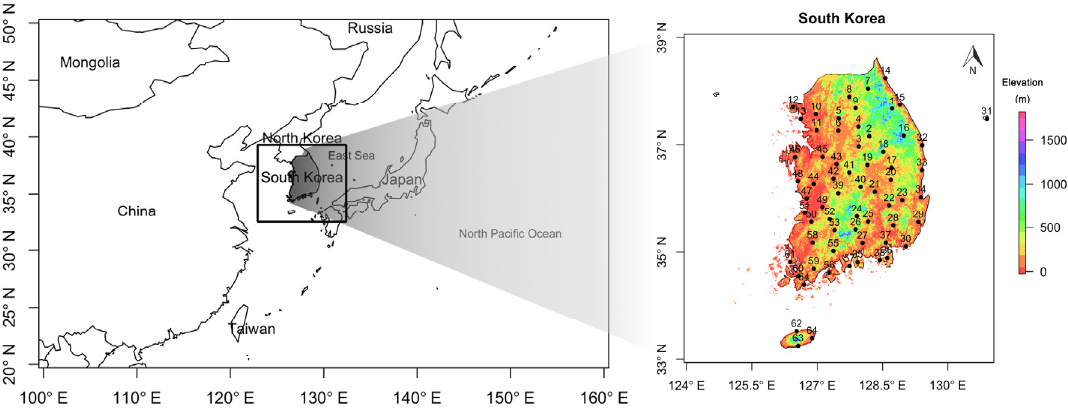
Figure 1. Location of the employed weather stations.